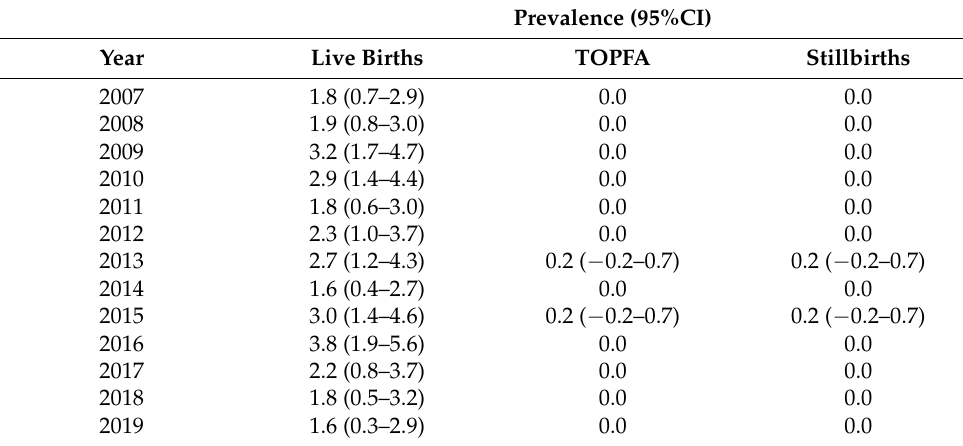
TOPFA: termination of pregnancy for fetal anomaly, 95% CI: 95% confidence